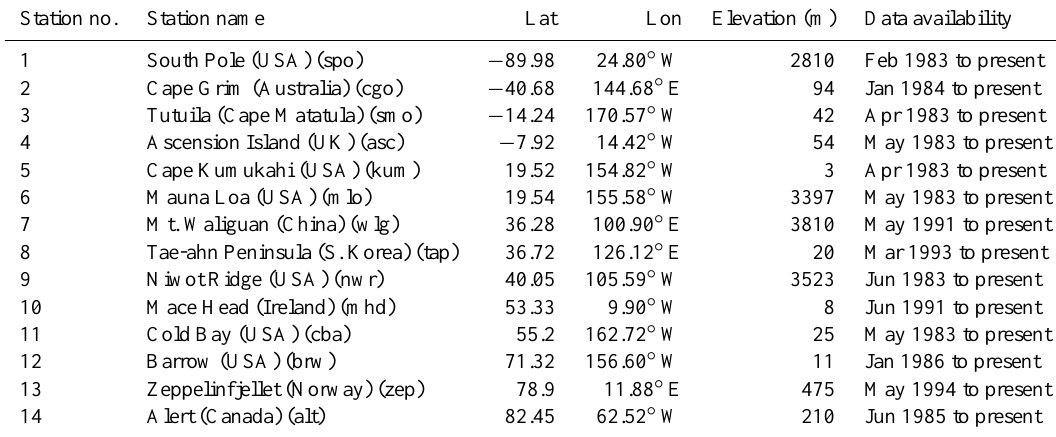
Table 2. A list of stations used in this study. Station